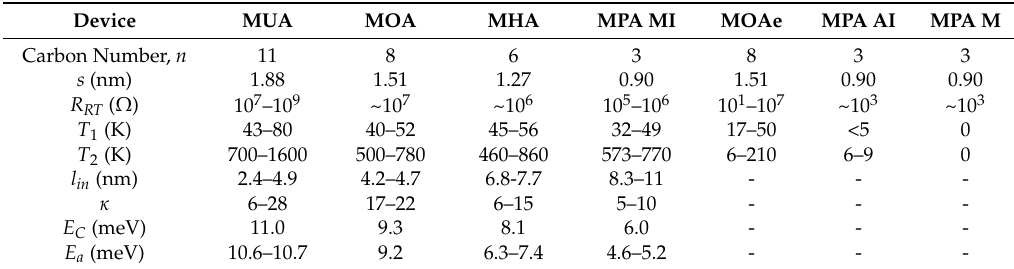
Table 1. Important parameters of the Au nanoparticle